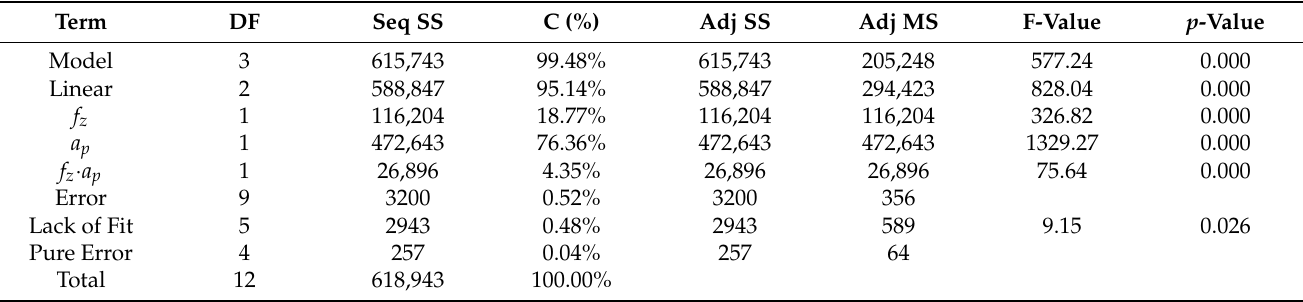
Figure 7. Normal-to-feed cutting force component F fN model. Table 4. Analysis of variance for the F fN cutting force component model.